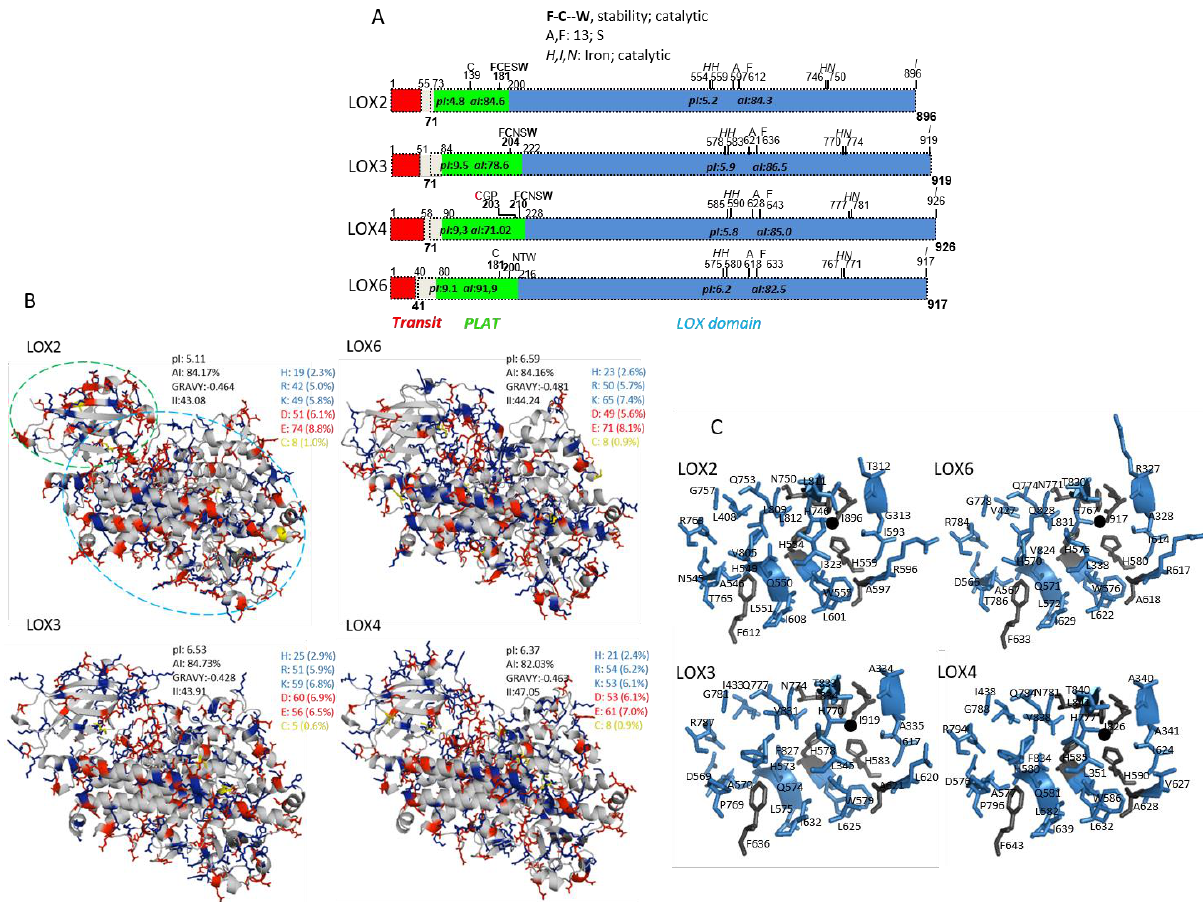
Figure 1. In silico analysis of At-13-LOXs. ( A ) Domain maps of 13-LOXs. ( B ) 3D models of 13-LOX enzymes, highlighting cysteinyl and charged amino acid residues. Tertiary structures of 13-LOX models, based on the crystal structure of SLOX (4wfo), are depicted in grey. Basic (K, R, H) and acidic (D, E) amino acid side-chains (AA) that are positively and negatively charged under physiological pH values are depicted as sticks in blue and red. Of the aliphatic index (AI) determining AA, only Cys (yellow) are shown. The amount and percentage of the pI value determining AA in each 13-LOX, together with Cys residues, are also listed. The PLAT and LOX domains exemplified for LOX2 are circled. ( C ) Active sites (backbone not shown) of 13-LOX are depicted in blue in reference to ( A ), with 13-S determining and catalytic residues highlighted in